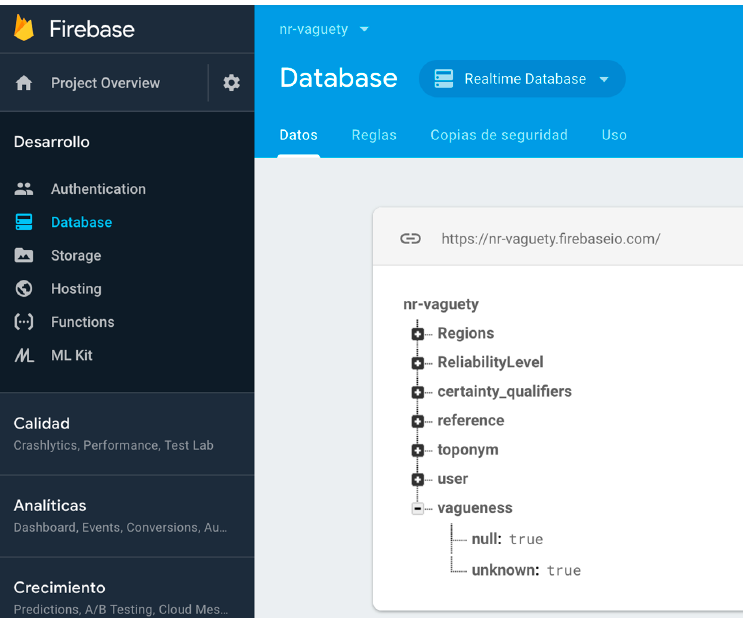
Figure 3. Firebase console showing the data node for defining null and unknown semantics.